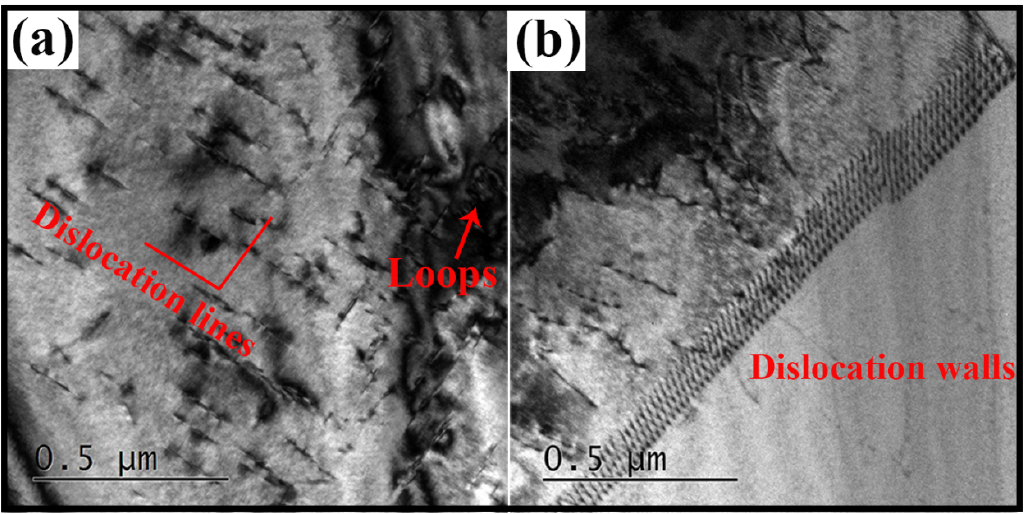
Figure 5. TEM micrographs of the 80% cross-rolled sample showing the formation of ( a ) dislocation lines and loops, and ( b ) dislocation walls in β matrix.